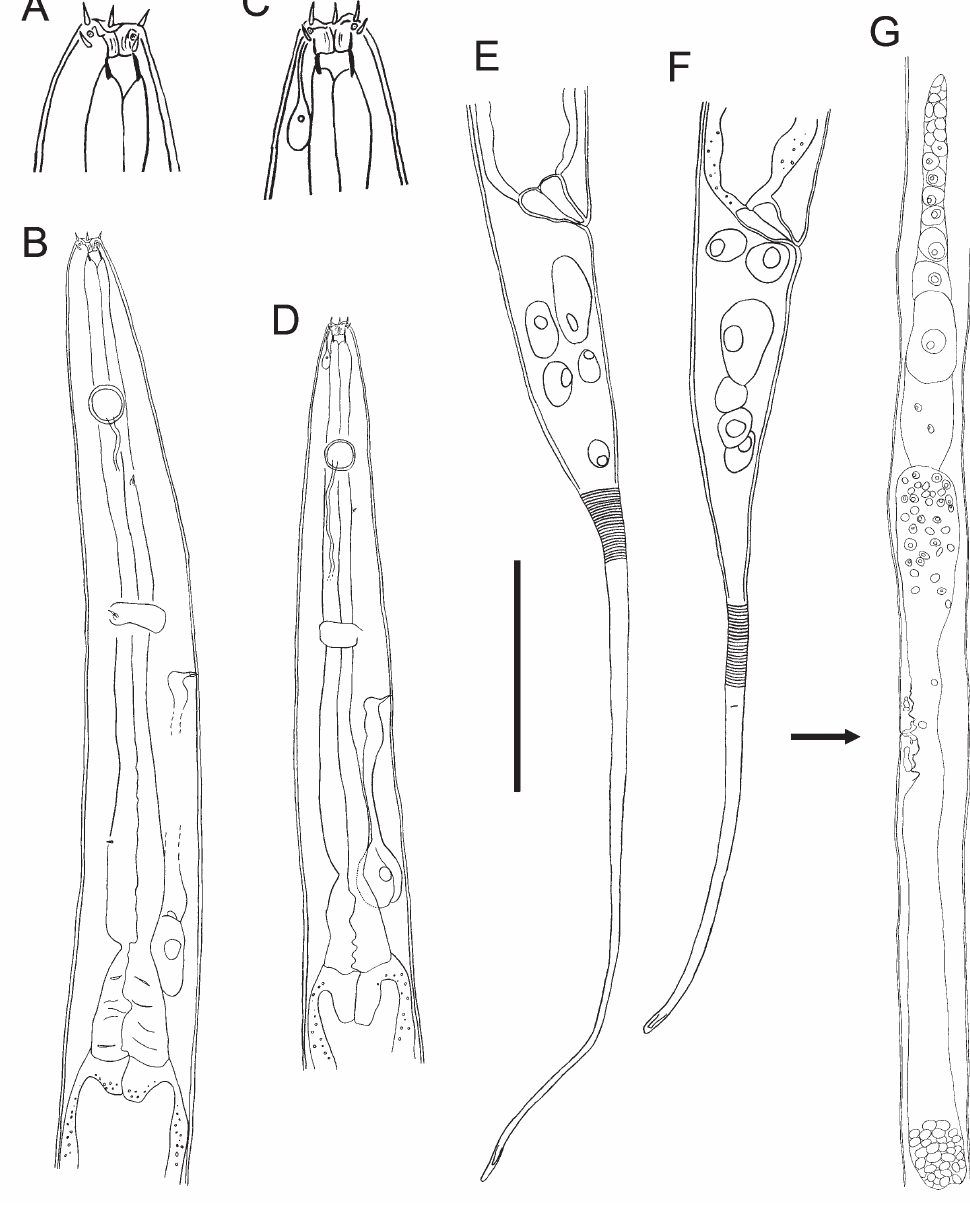
Fig. 2. Thelonema clarki sp. nov. Paratypes, ♀ and juvenile. A . Female head. B . Female anterior body region. C . Juvenile head. D . Juvenile anterior body region. E . Female posterior body region. F . Juvenile posterior body region. G . Female reproductive system. Arrow shows position of vulva. Scale bar: A–c = 40 µm; B–D = 100 µm; e–F = 90 µm; G = 210